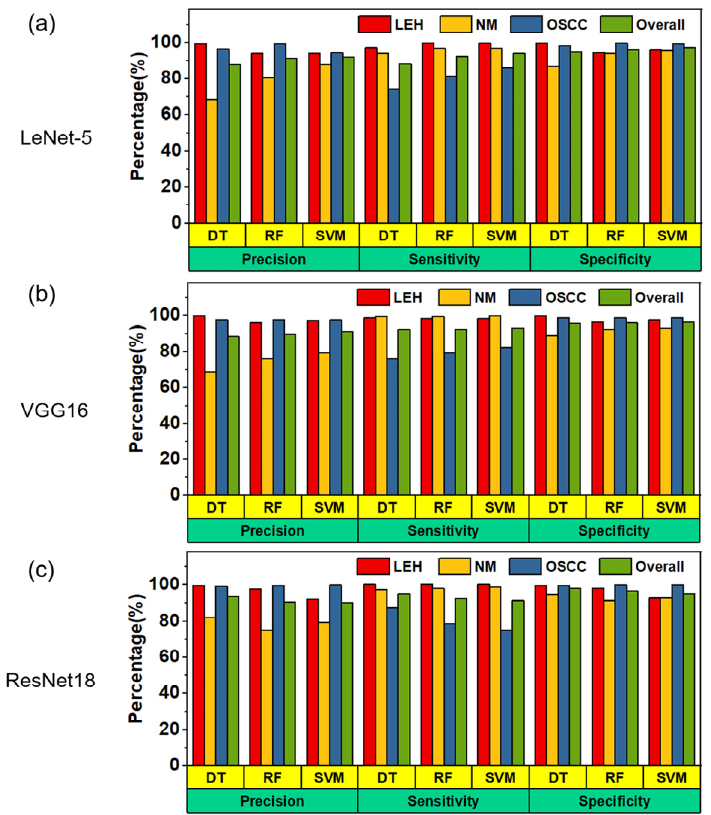
Figure 4. The performance comparison of the three classifiers (DT, RF, and SVM) when using LeNet-5 ( a ), VGG16 ( b ), and ResNet18 ( c ) as a feature extractor, respectively.